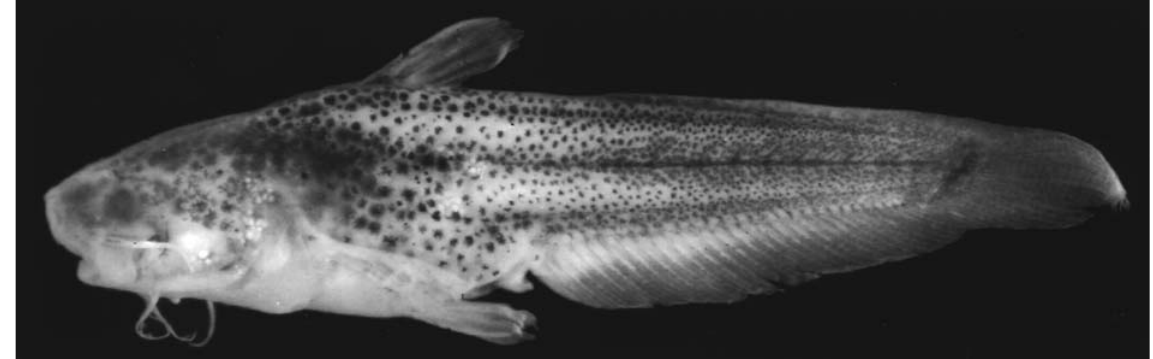
Fig. 51. Denticetopsis royeroi, holotype, MBUCV V-26785, 18.5 mm SL; Venezuela, Amazonas, Caño Chola, at crossing of road from San Carlos de río Negro to Solano (1°58’N, 67°00’W) (photo taken shortly after